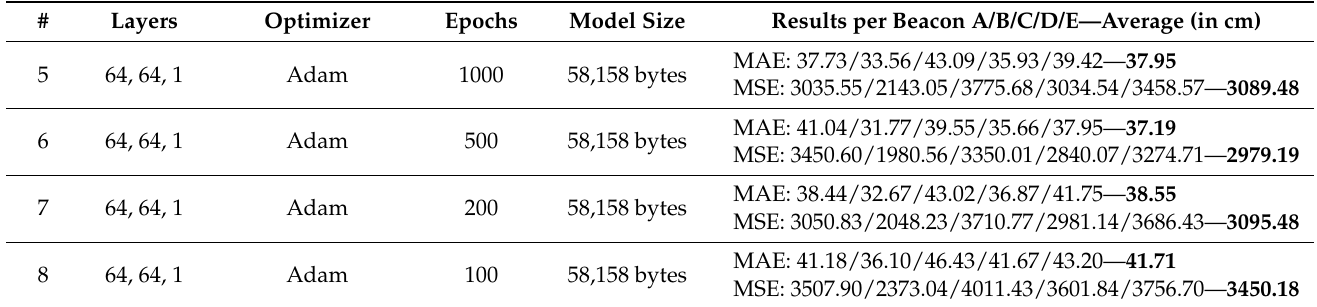
Table 4. Experiments No. 5, No. 6, No. 7, and No. 8 parameters and